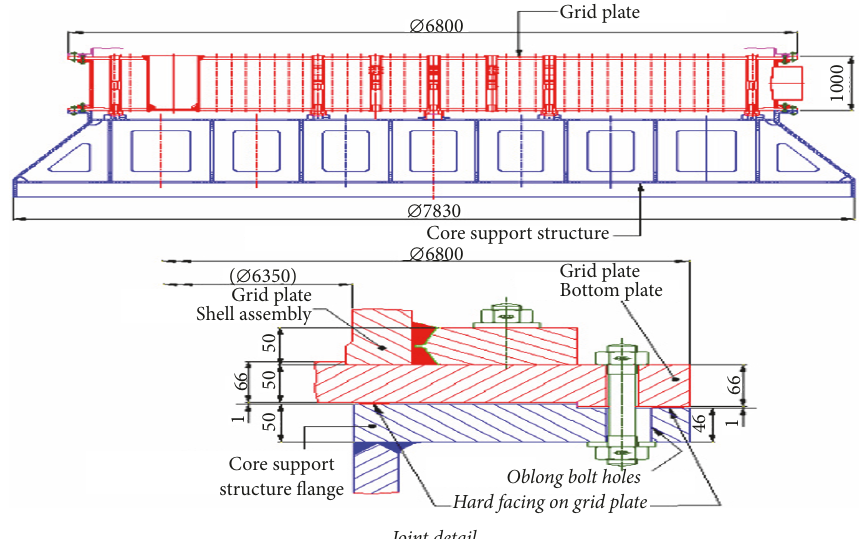
Figure 1: Bolted construction of the grid plate with the hardfacing region (http://www.igcar.ernet.in).